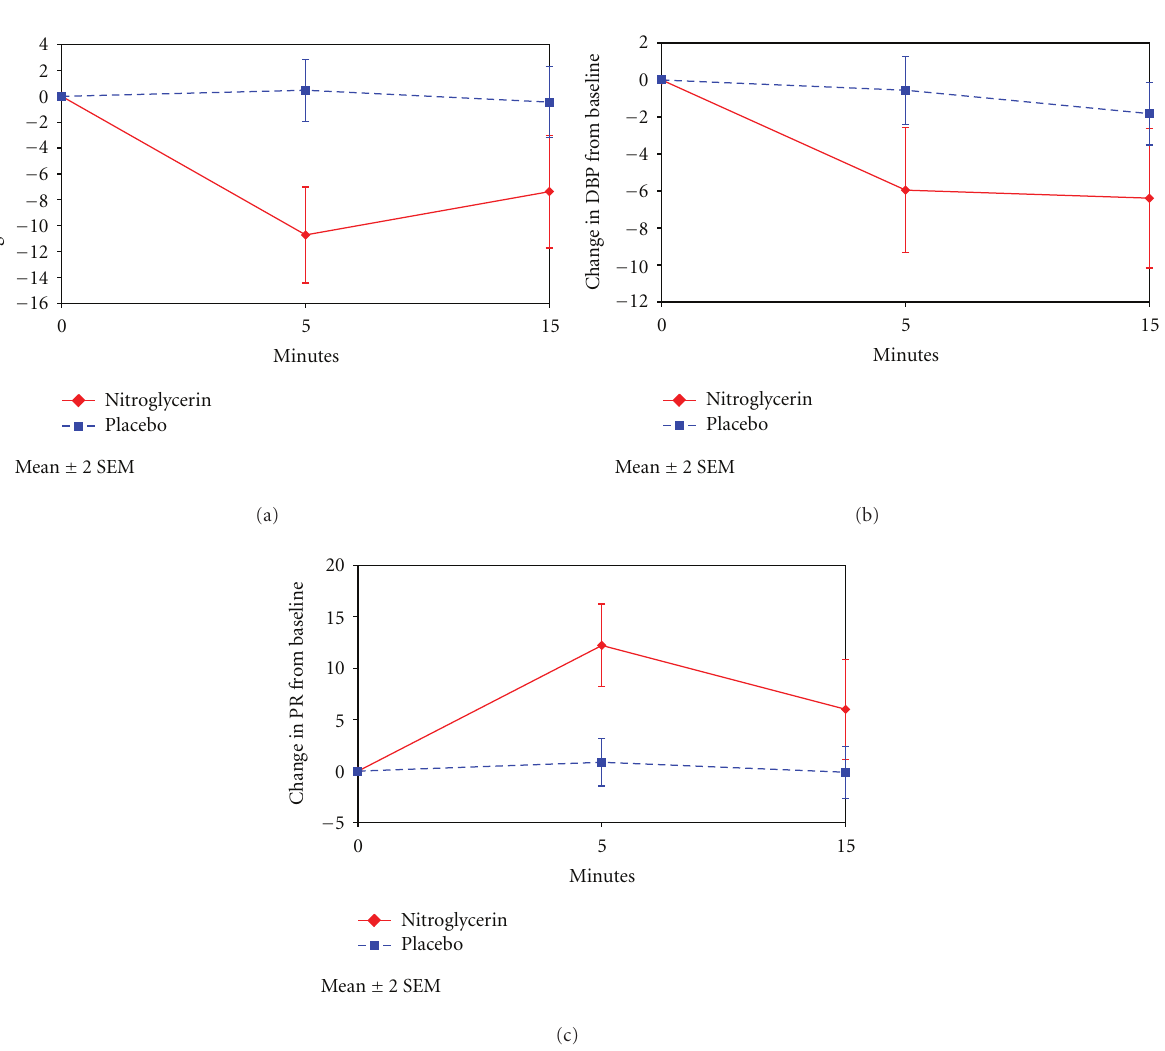
Figure 1: Systolic blood pressure (SBP), diastolic blood pressure (DBP), and pulse rate (PR) at baseline, 5 and 15 minutes after administration of either nitroglycerin or placebo tablets. All parameters showed di ff erences of statistical significance between the groups ( P < 0 . 05) following administration of the